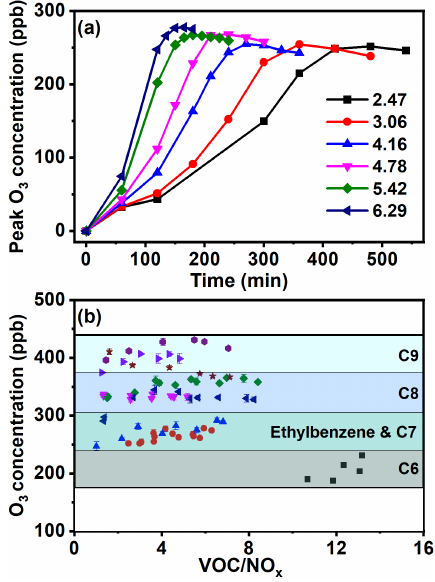
trated O 3 was observed from AH photochemical oxidation. Figure 3. (a) O 3 formation curve of toluene photochemical oxi-